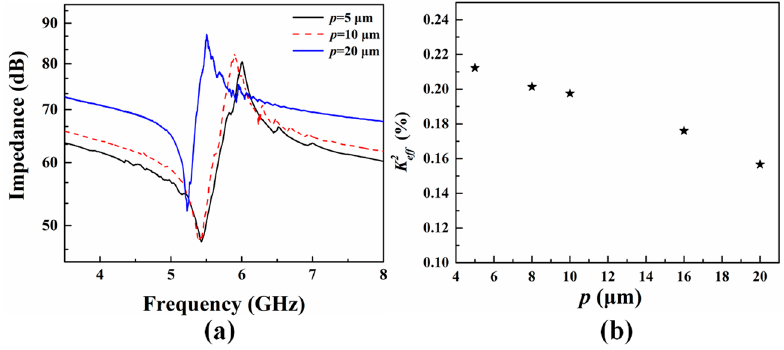
Figure 8. The measured impedance curve and 𝐾 (cid:3032)(cid:3033)(cid:3033)(cid:2870) with different pitch ( p ). ( a ) The measured impedance curve of resonator with different pitch ( p ). ( b ) The measured 𝐾 (cid:3032)(cid:3033)(cid:3033)(cid:2870) vs. different pitch ( p ).